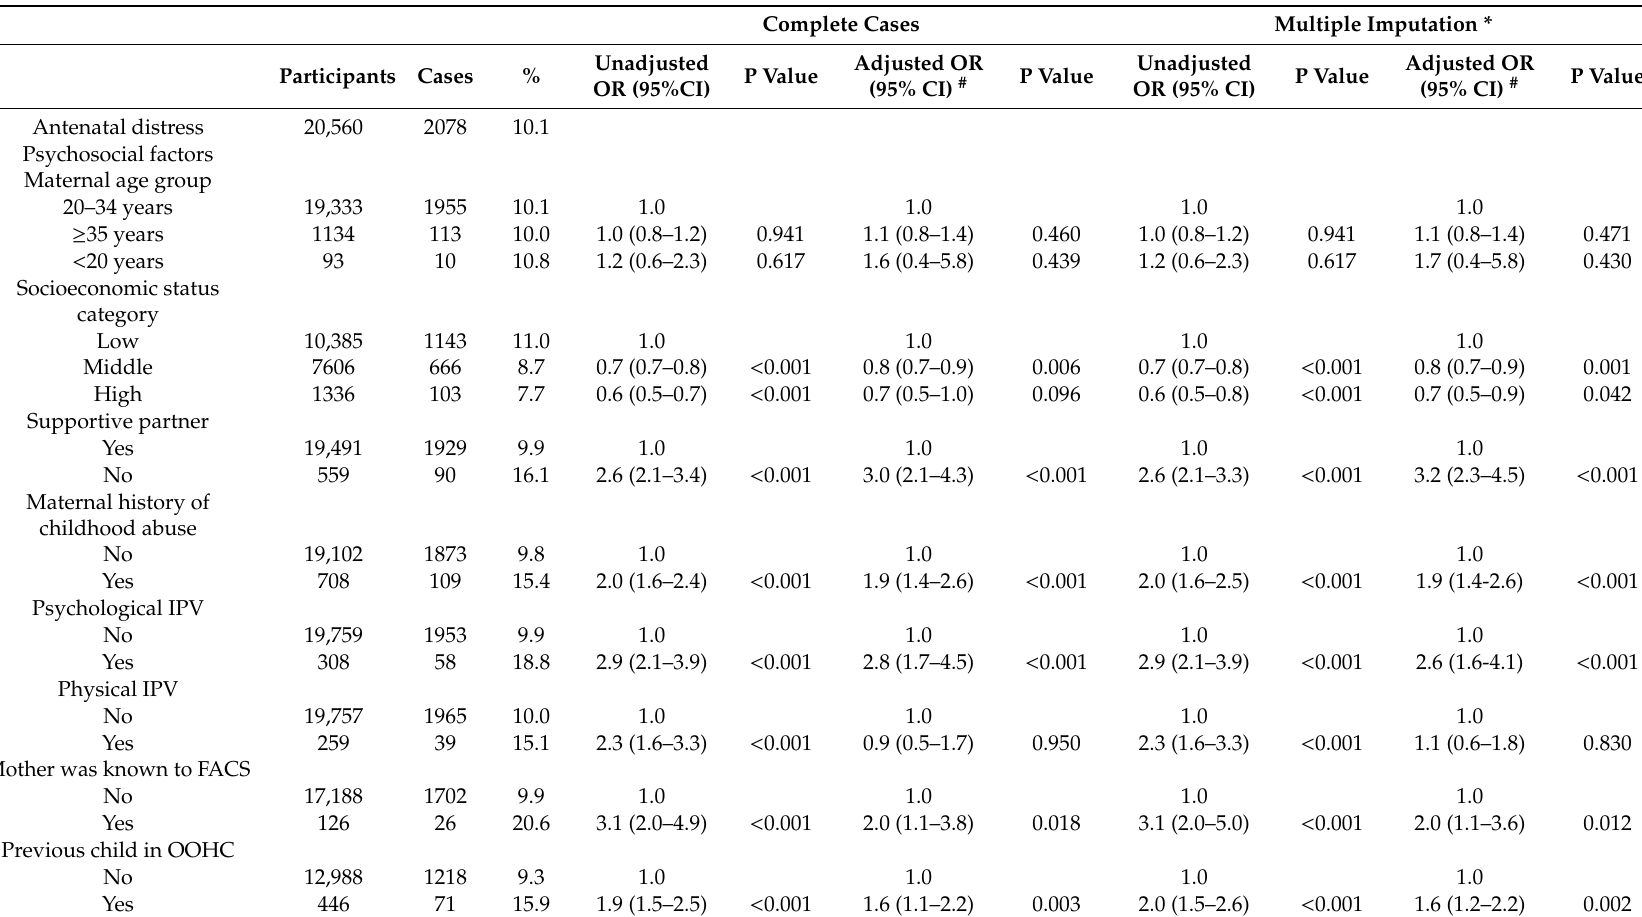
Table 1. Associations between the study factors and antenatal distress (EPDS = 10–12) in South Western Sydney and Sydney Local Health Districts,